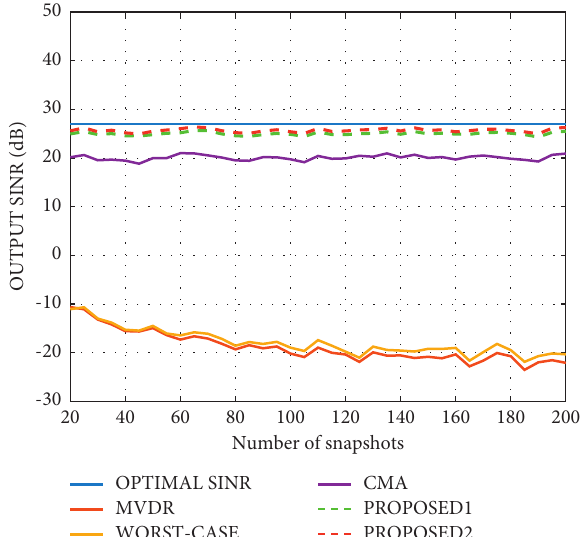
Figure 12: Random SV mismatch: output SINR versus the number of